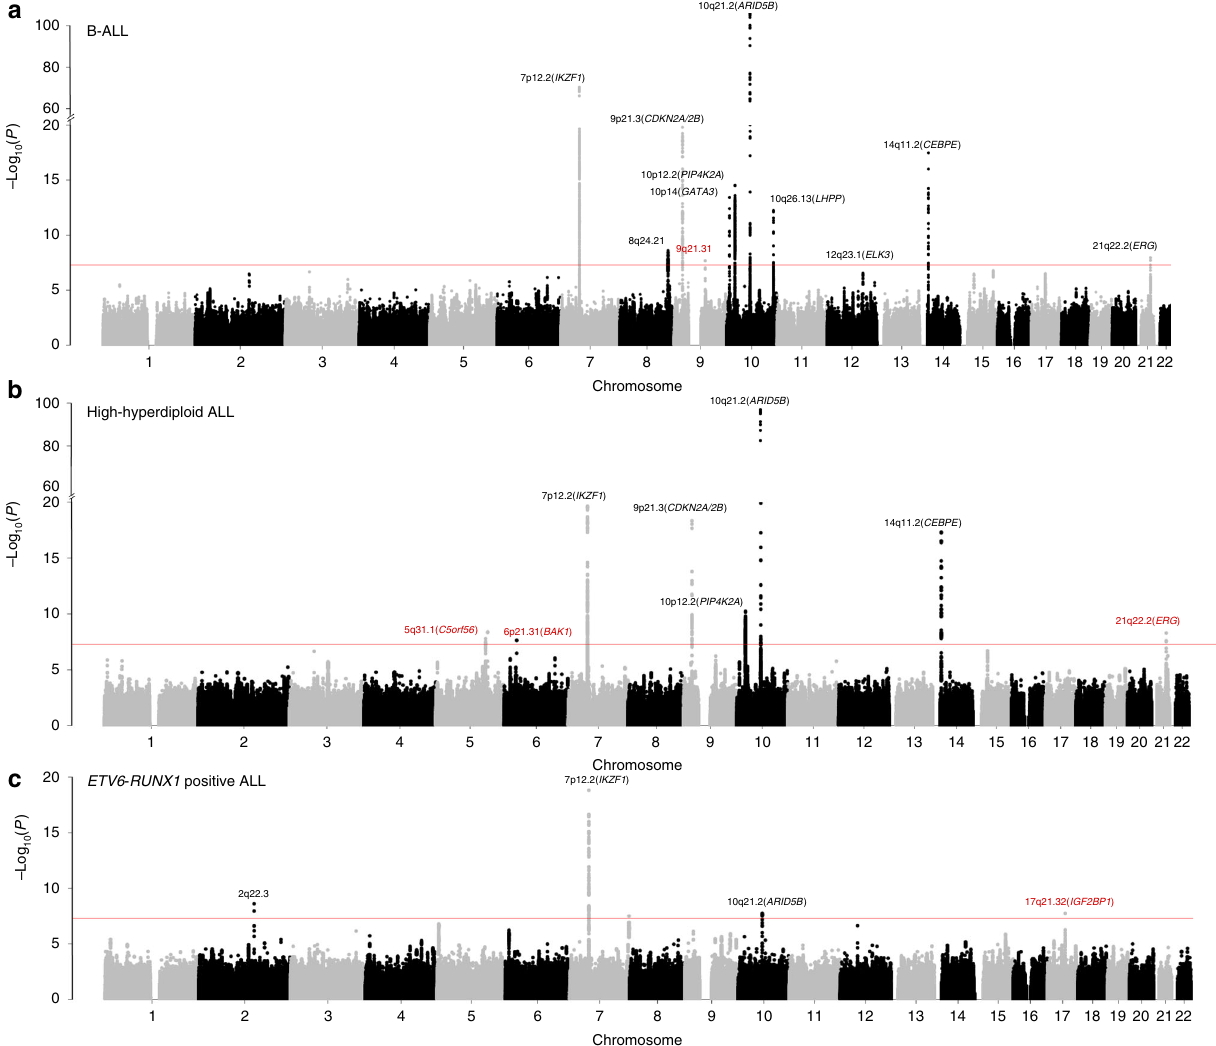
Fig. 1 Manhattan plots of association for a B-ALL, b high-hyperdiploid ALL and c ETV6-RUNX1 -positive ALL. y -axis shows genome-wide P -values (two- sided, calculated using SNPTEST v2.5.2 assuming an additive model) of > 6 million successfully imputed autosomal SNPs in 5321 cases and 16,666 controls. The x -axis shows the chromosome number. The red horizontal line represents the genome-wide signi fi cance threshold of P = 5.0 × 10 − 8 . New associations are labelled in red. Other risk loci were reported in previous GWAS using subsets of ALL cohorts included